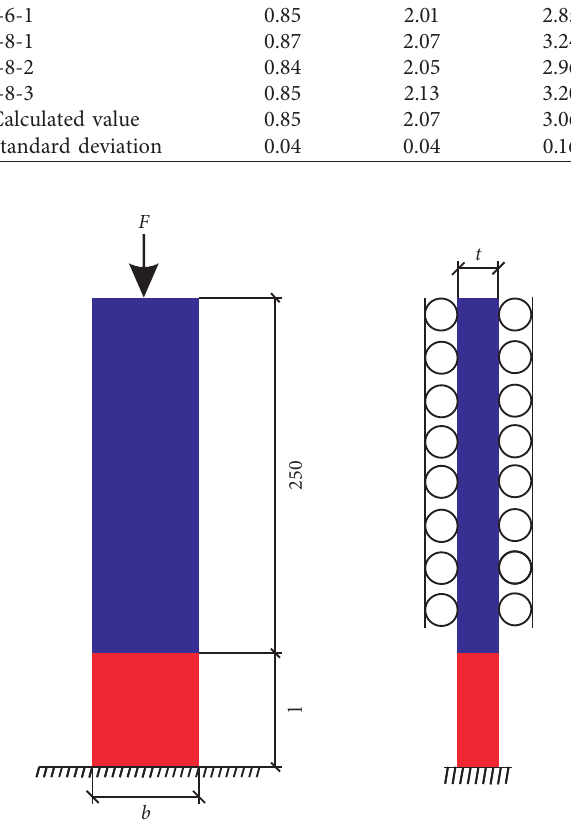
Figure 6: FE model and boundary